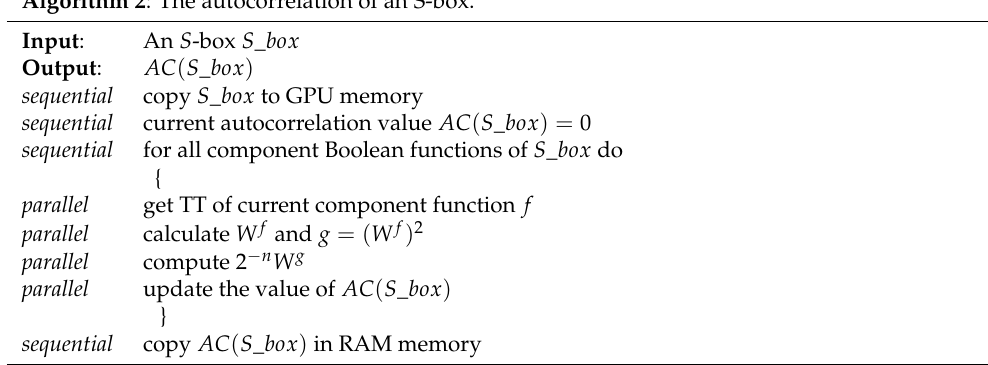
Algorithm 2 : The autocorrelation of an